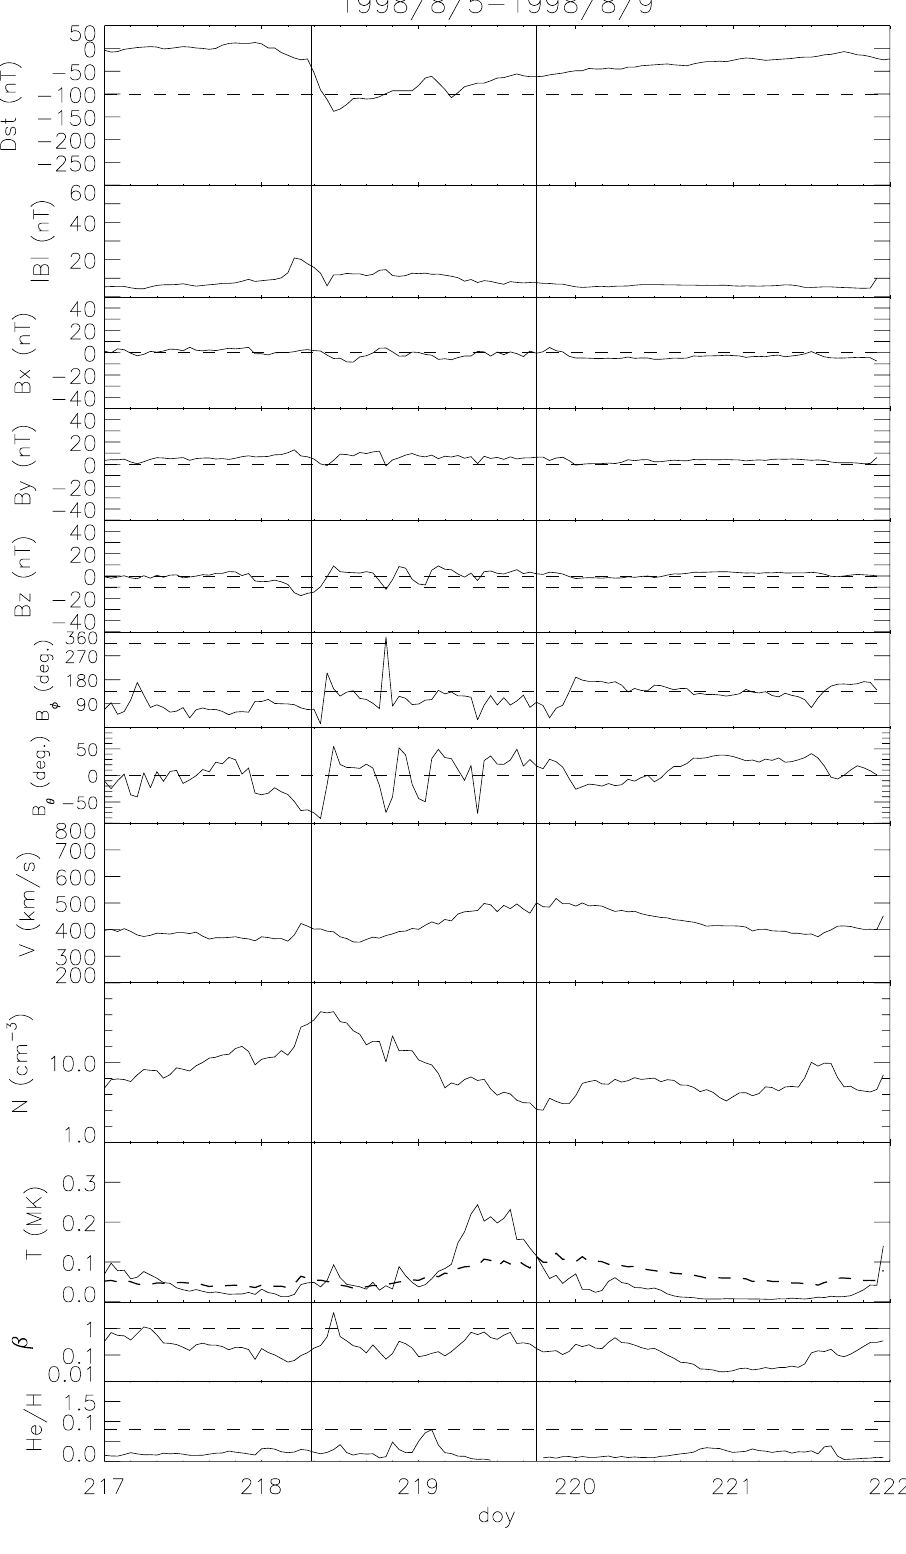
Fig. 12. D st index and solar wind parameters of storm no. 5. Two vertical solid lines show the duration of the geomagnetic